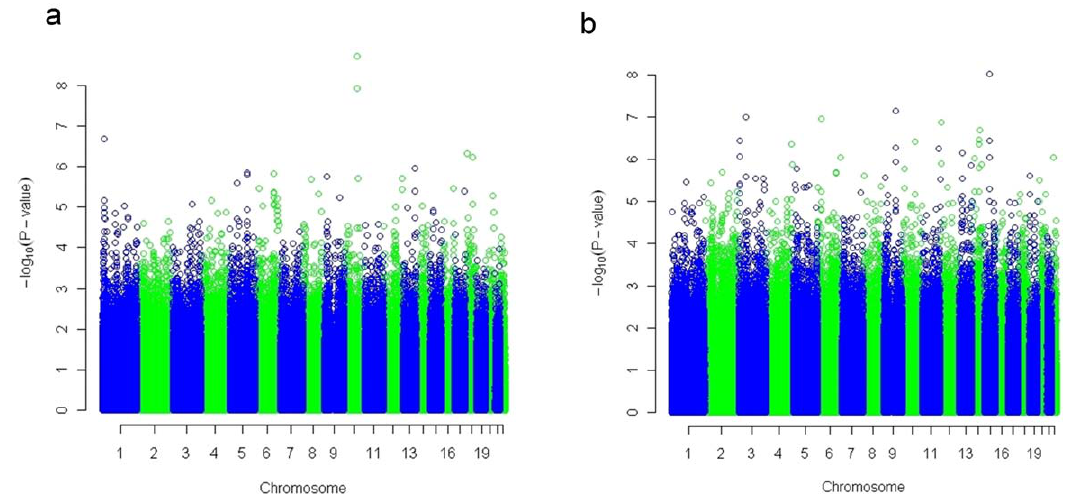
Figure 4. Genomic distribution of p-values from association tests. Successive chromosomes are shown in alternating colours on the plot. Results from the CEU and YRI populations are shown in panels a and b, respectively.